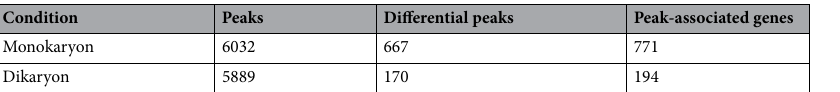
Condition Peaks Differential peaks Peak-associated genes